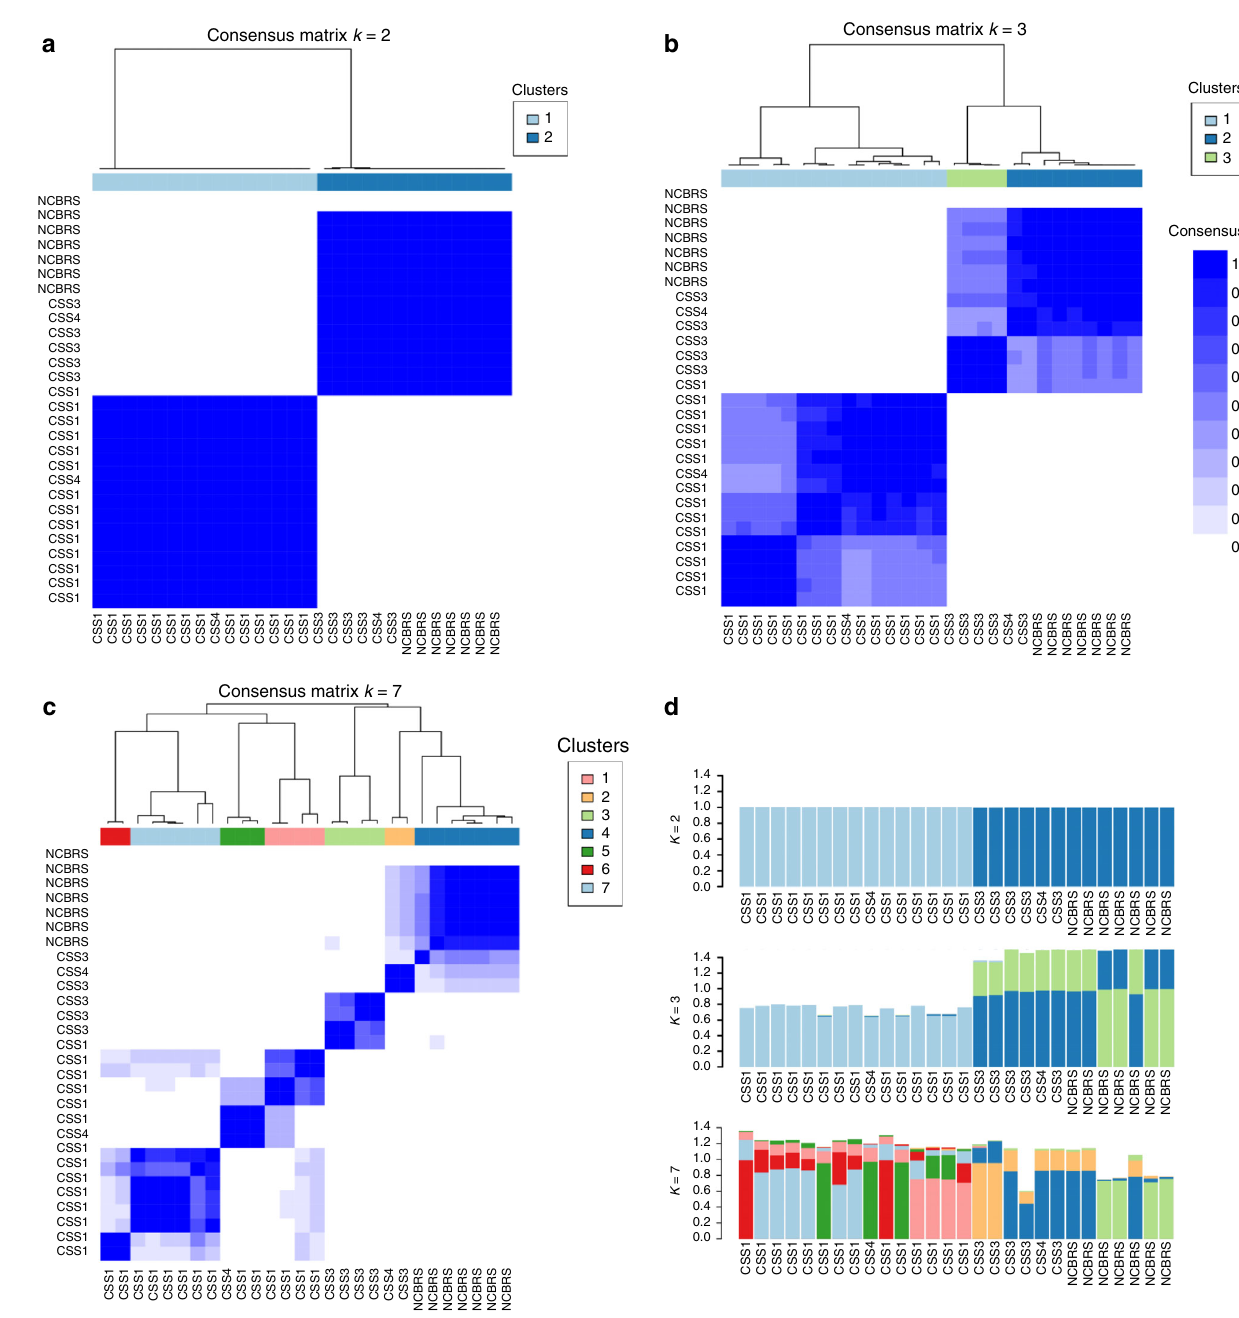
Fig. 3 Consensus clustering analysis of CSS/NCBRS patients. A 1000 repeat iterations of K -means clustering on Spearman ’ s distance was performed, each for a random 80% subsampling of all signi fi cant probes and patients, for clustering counts ( k ) 2 – 10. The most stable cluster (optimal k ) was determined using the PAC measure as two (Supplementary Figure 12). a , b , c Consensus cluster heatmaps at k = 2, 3, and 7. Both rows and columns are samples. The intensity of blue represents how often every two samples from the rows and columns cluster together in the 1000 repeat iterations. The pane on top demonstrates the consensus cluster for each sample. At k = 2, CSS3 and NCBRS samples always cluster together while they never group with CSS1 samples. As the k increases, more clusters are identi fi ed within the initial two groups. At k = 7 ( c ), CSS3 subjects for the fi rst time belong to clusters with no NCBRS membership, while at the same time a larger number of clusters are formed within the initial CCS1 class. d Item-consensus plots for heatmaps in a – c . Every subject has an item-consensus value for each of the identi fi ed clusters at different k s, as indicated by the segmental lengths of the bars, representing the level of consensus of that sample with the members of other clusters (indicated by cluster label colors). The plot at k = 2 shows that none of the two clusters contain any consensus with members of the other, being very pure members of their own clusters. As the k increases, the purity is reduced. At k = 7, all of the samples in NCBRS cluster (dark blue) harbor >20% consensus with the two samples in the yellow cluster (composed of CSS3 and CSS4). These two samples also show the same amount of consensus with NCBRS members, but they have very little consensus with the light green cluster, composed of other CSS3 samples, suggesting that these clusters do not represent differences between CSS3 and NCBRS. None of these patterns are related to batch effect. The three k s represented here were chosen as they harbor subdivisions within the CSS-NCBRS cluster. For complete data see Supplementary Figures 2 –